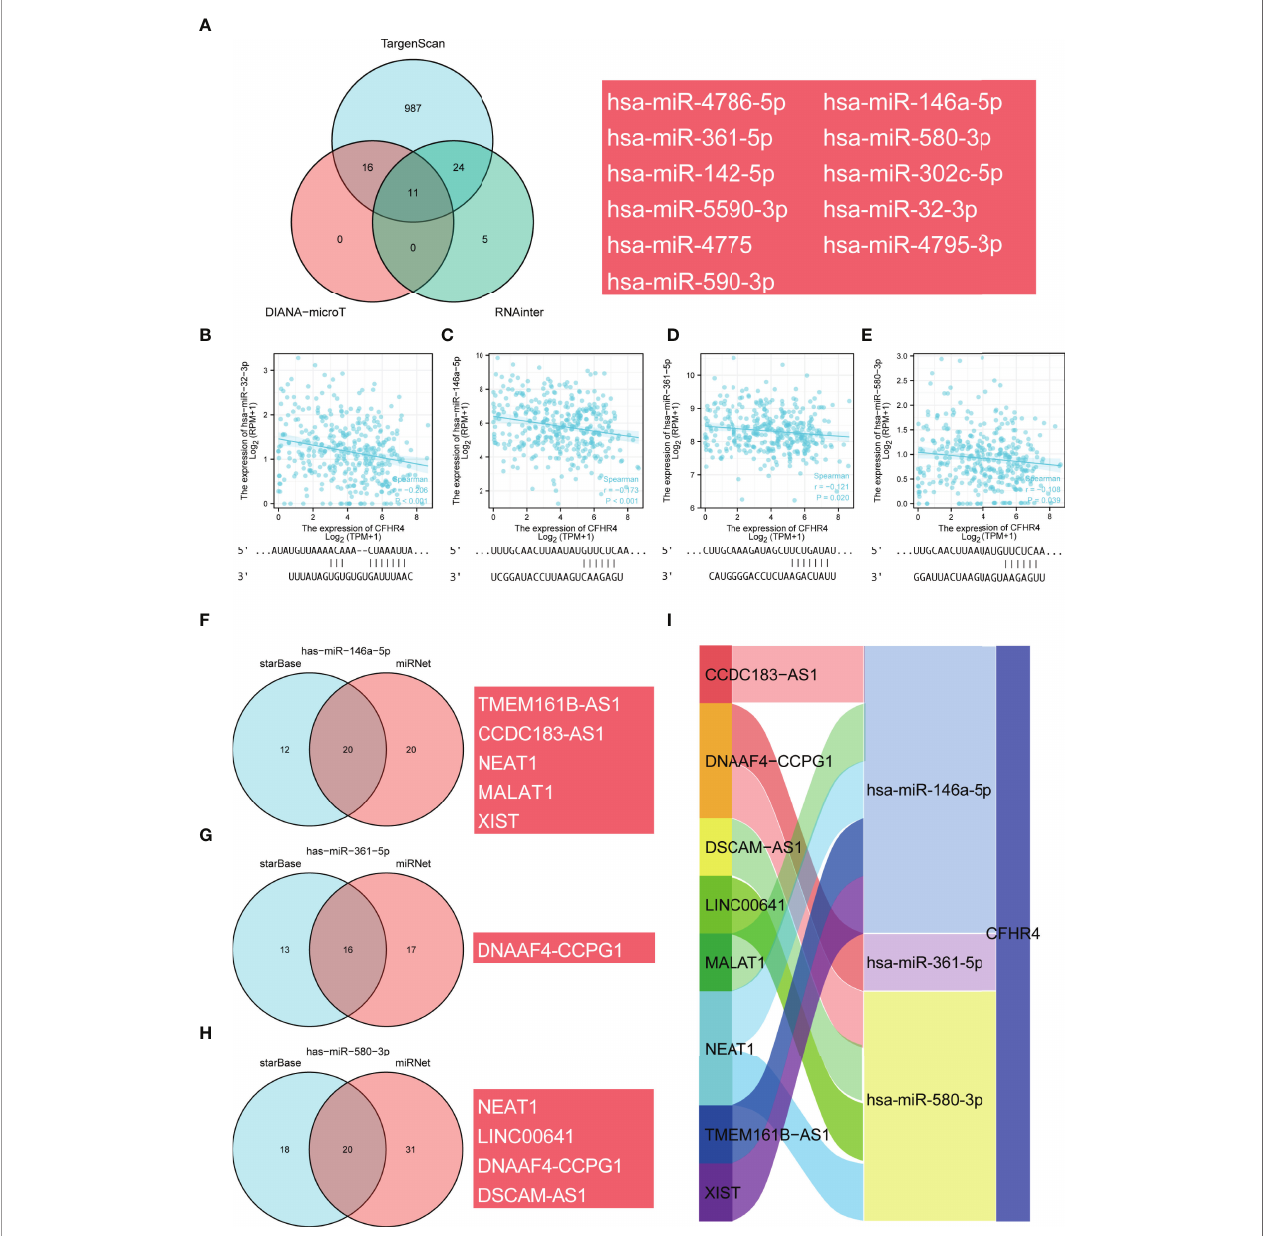
FIGURE 8 | Prediction of the ceRNA network in HCC. (A) Venn diagram showing the results for CFHR4 targets predicted using the TargetScan, DIANA-microT and RNAinter databases. (B – E) Scatter plots were generated to show miRNAs-mRNAs with signi fi cant correlations. TargetScan prediction of the potential binding sites in CFHR4 for the target miRNAs. (F – H) The lncRNAs that bind to target miRNAs were predicted using the miRNet and starBase online databases and displayed in a Venn diagram, including hsa − miR − 146 − 5p, hsa − miR − 361 − 5p and hsa − miR − 580 − 3p. (I) Sankey diagram showing the CFHR4-related ceRNA regulatory